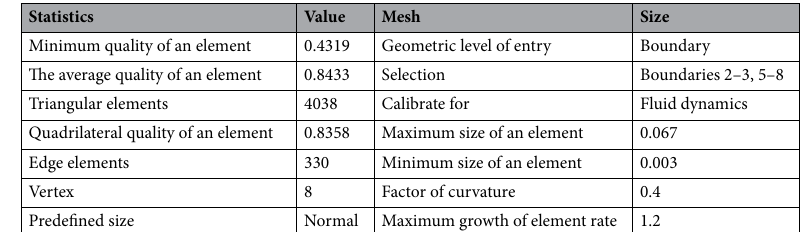
Normal Maximum growth of element rate 1.2 Table 2. Description of mesh statistics and mesh size.